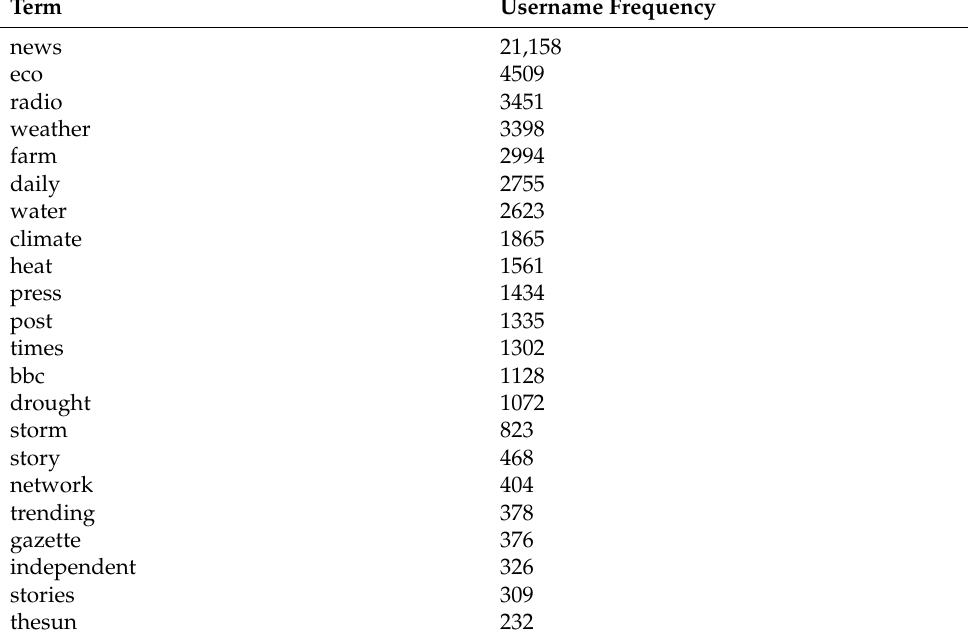
Table A1. Common terms in usernames excluded from analysis. This list was derived through manual observation of active weather stations or news accounts. These accounts did not provide a social perspective to heatwaves and were